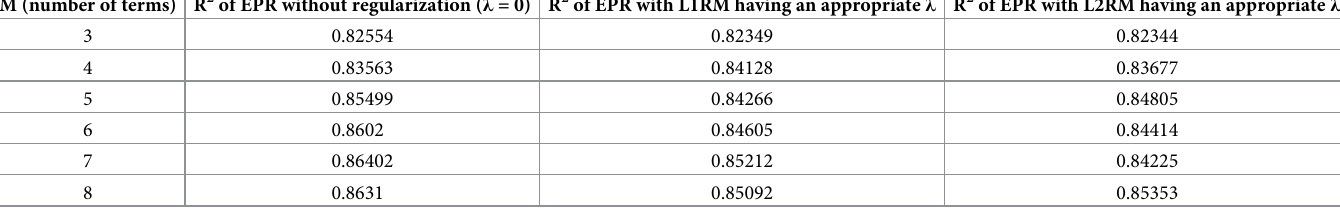
Table 3. Comparisons of R 2 with different λ